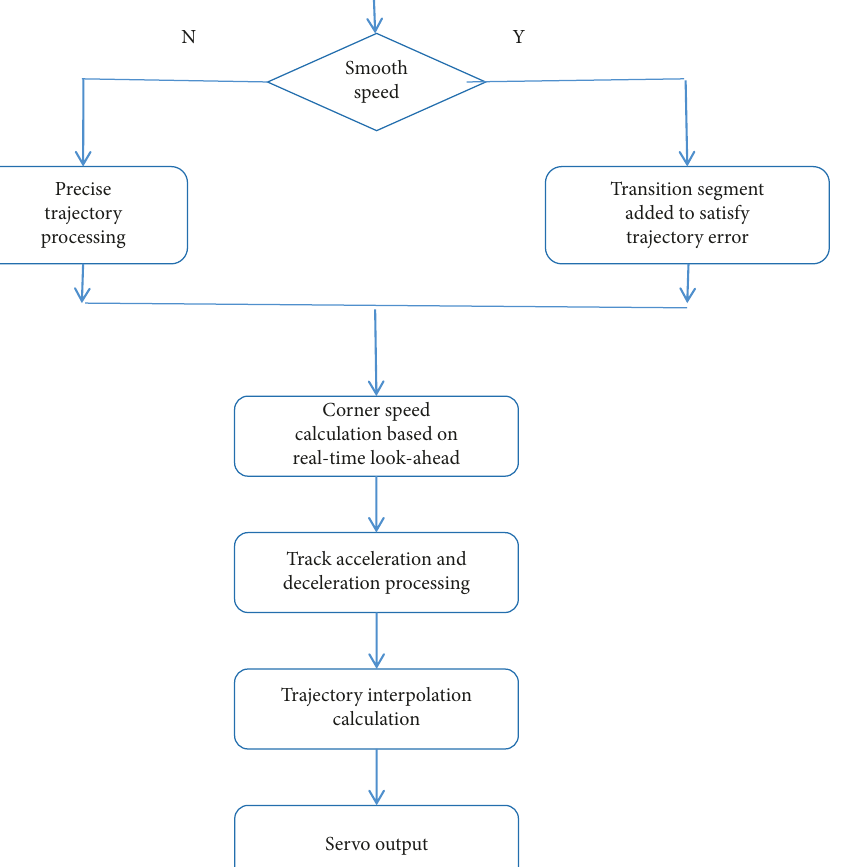
Figure 2: Transition processing flow at the corner of the motion